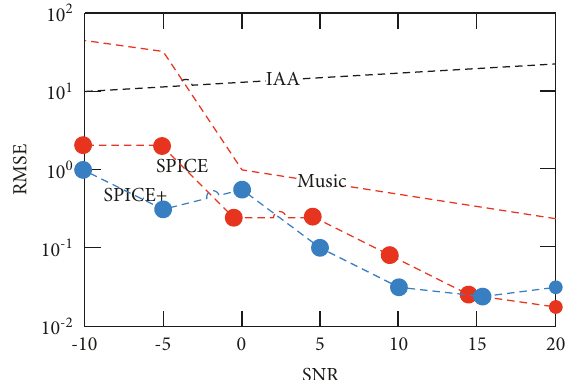
Figure 8: RMSE results with coherent sources.